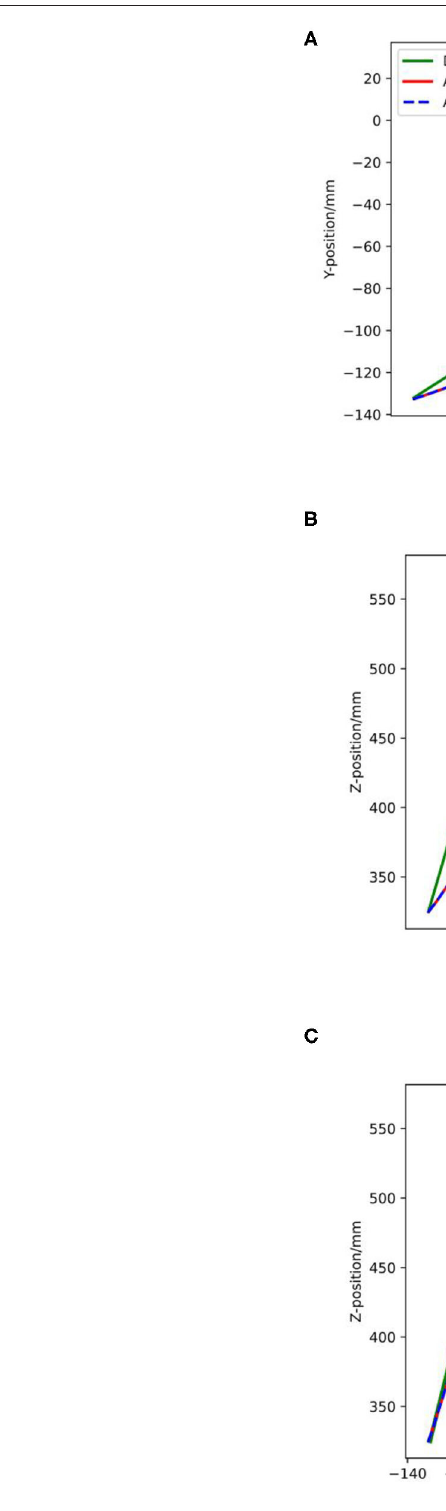
Frontiers in Neurorobotics |